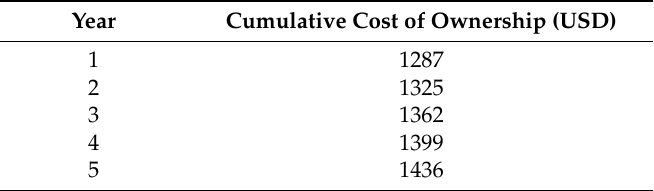
Table 1. The projected cumulative cost for owning a Lulzbot Mini increased from year 1 to 5. The cost includes the price of the printer itself, the cost of the filament, and the energy consumption to print an average product per